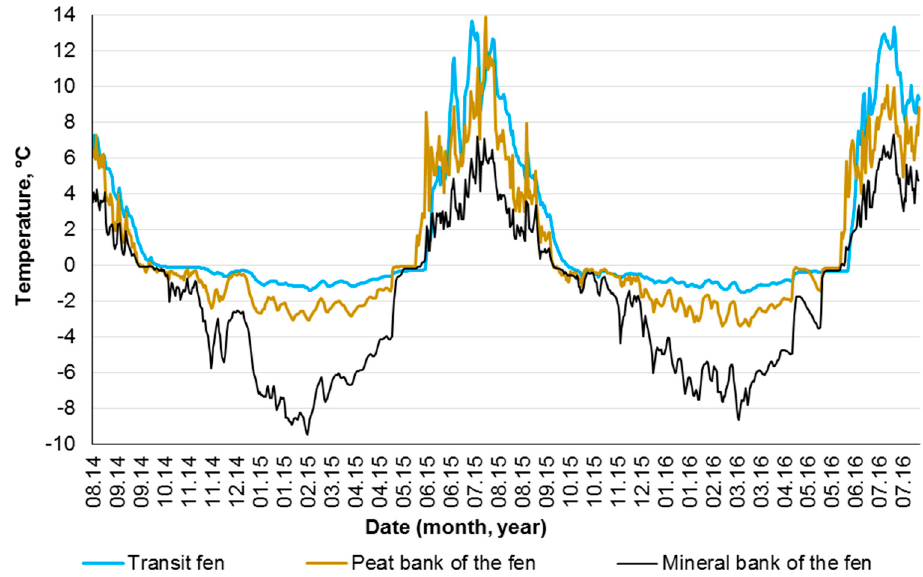
Figure 8. Soil temperature changes at a depth of 5 cm in the transit fen and bank of the fen. The fen is located on the edge of the polygonal bog within the KS Tazovsky in the southern tundra.